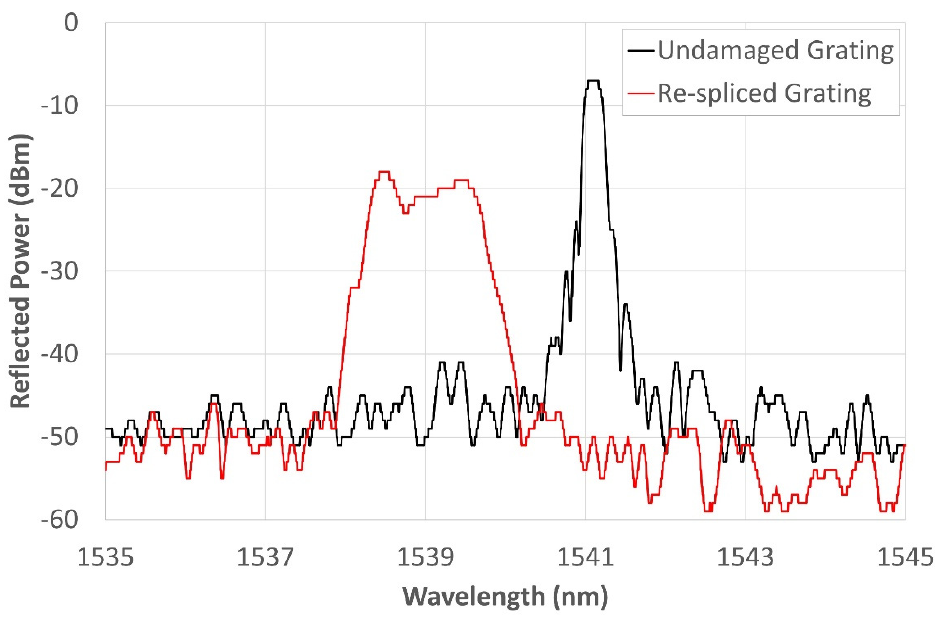
Figure 2. Comparison between the spectra of the same grating before and after intentional breaking and subsequent